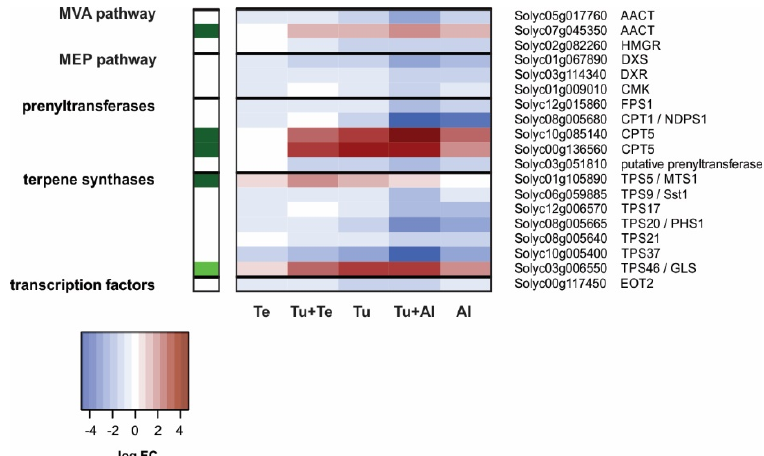
Figure 6. Gene-expression heat map depicting the relative transcript levels of tomato ( Solanum lycopersicum ) genes that encode proteins with a (predicted) function in terpenoid biosynthesis and that were differentially expressed in leaves after seven days of infestation with herbivorous mites. Tomato leaves were infested with either a single mite species ( Tetranychus urticae (Tu), Tetranychus evansi (Te), or Aculops lycopersici (Al)) or two species simultaneously ( T. urticae plus T. evansi (Tu+Te), or T. urticae plus A. lycopersici (Tu+Al)). Non-infested plants served as controls and were used as a common reference in the transcriptional comparisons. Presented genes were differentially expressed (Benjamini and Hochberg false discovery rate adjusted p ≤ 0.05; Log 2 fold change (FC) ≥ 0.585) in at least one of the mite-infestation treatments. The different (sub)sections of the pathway are specified on the left. Dark green squares in the leftmost column denote that transcription of the respective gene was found to be significantly induced in the tomato jasmonic acid (JA)-biosynthesis mutant def-1 , 24 h after exogenous application of JA (for details see [39]). The light green square denotes JA-inducibility of the respective gene according to [97]. Firstly, we noted the strong, simultaneous down-regulation of CPT1/NDPS1 and TPS20/PHS1 in tomato leaves (dual) infested with A. lycopersici (Figure 6). These genes appeared to be down- regulated in Tu samples as well, but this was not statistically significant. CPT1/NDPS1 is one of the most strongly down-regulated genes in the Al samples (Table S6; #3) and encodes a neryl diphosphate (NPP)-producing cis-prenyltransferase [98]. The terpene synthase (TPS) encoded by TPS20/PHS1 catalyzes the conversion of NPP into several monoterpenes (C 10 ), including α- and β-phellandrene [98]. The highly reduced expression of CPT1/NDPS1 and TPS20/PHS1 in A. lycopersici -infested leaves suggests that phellandrene may be emitted in lower amounts by these plants as compared to non-infested controls. Although the magnitude of FCs was smaller than for CPT1/NDPS1 and TPS20/PHS1 , we found similar expression patterns for TPS17 and TPS21 (Figure 6). TPS17 encodes a sesquiterpene (C 15 ) synthase [99] and TPS21 a diterpene (C 20 ) synthase [100]. The main reaction products of these enzymes are valencene and lycosantalene, respectively [99,100]. Secondly, consistent with the increased emission of the monoterpene linalool, the sesquiterpene ( E )-nerolidol and the homoterpene (C 16 ) ( E , E )-4,8,12-trimethyltrideca-1,3,7,11-tetraene (TMTT) in response to T. urticae feeding [37], expression of two TPS genes involved in the biosynthesis of these compounds, i.e., TPS5/MTS1 and TPS46/GLS , was significantly up-regulated in Tu samples. The trichome-localized TPS5/MTS1 preferentially produces linalool from geranyl diphosphate (GPP), yet can also generate ( E )-nerolidol from farnesyl diphosphate (FPP) [101]. TPS5/MTS1 was induced in Tu+Te as well, but not in leaflets (dual) infested with A. lycopersici . TPS46/GLS, uses geranylgeranyl diphosphate (GGPP) as a substrate to produce the diterpene geranyllinalool [97], which is the precursor of TMTT. The enzyme(s) responsible for the conversion of geranyllinalool into TMTT has/have not been identified in tomato. Although enzymatically less efficient, TPS46/GLS can synthesize ( E )-nerolidol from FPP [97]. TPS46/GLS expression was up-regulated upon all mite infestation treatments, except for the single infestation with T. evansi . It should be noted that whereas TPS5/MTS1 was induced by T. urticae feeding, TPS37 was down-regulated (also in Tu+Te, Tu+Al and